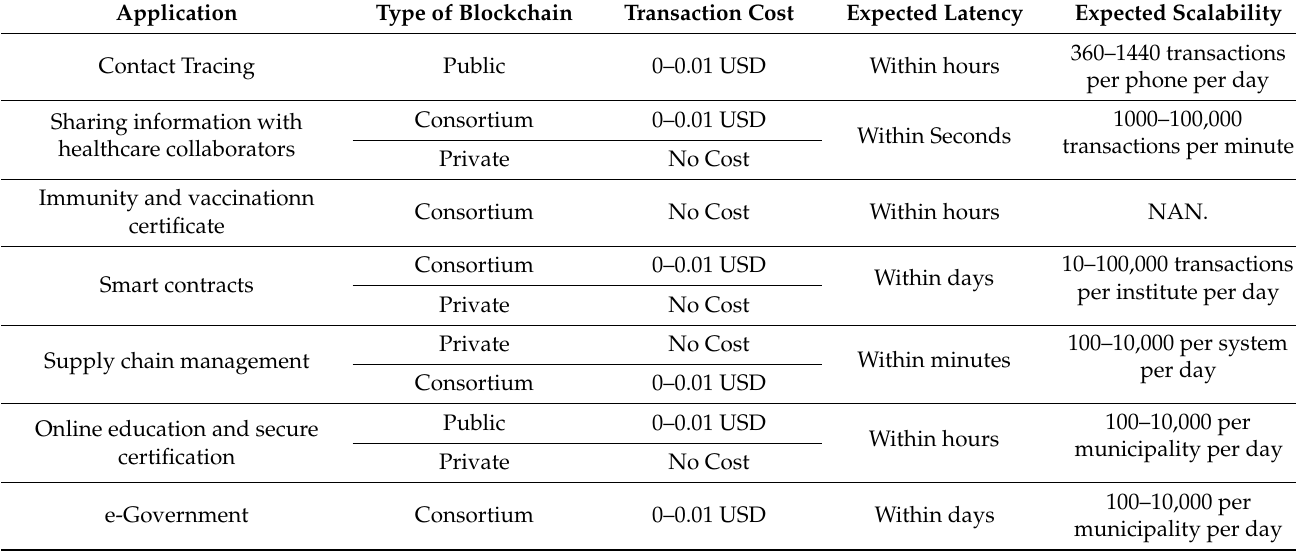
Table 2. Existing applications for blockchain